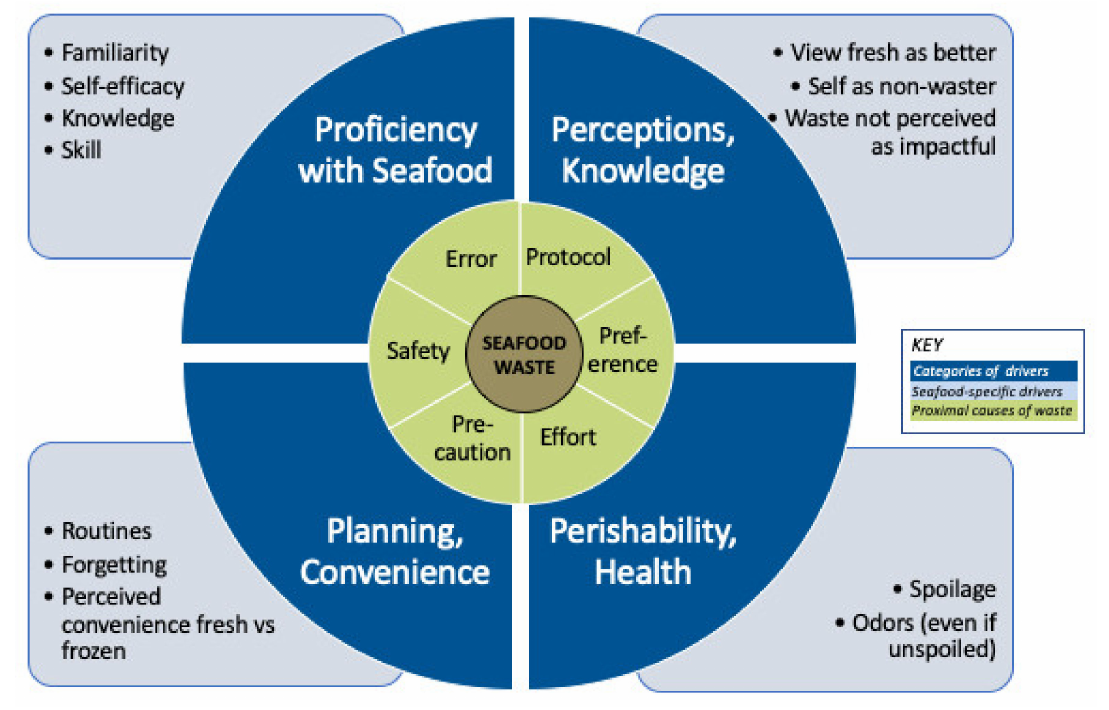
Figure 3. Seafood Waste Drivers Concept